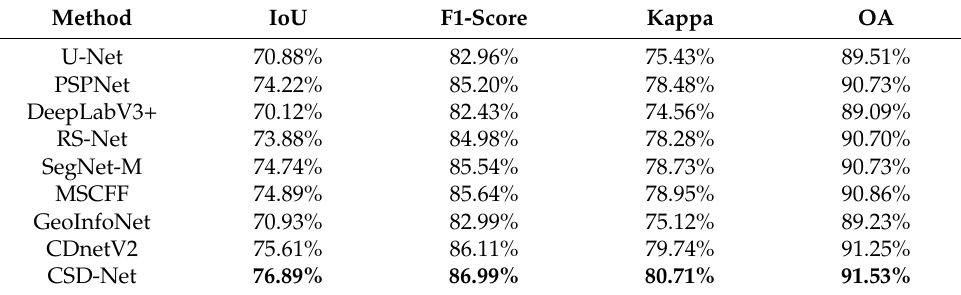
Table 10. The quantitative evaluation comparison on the Biome